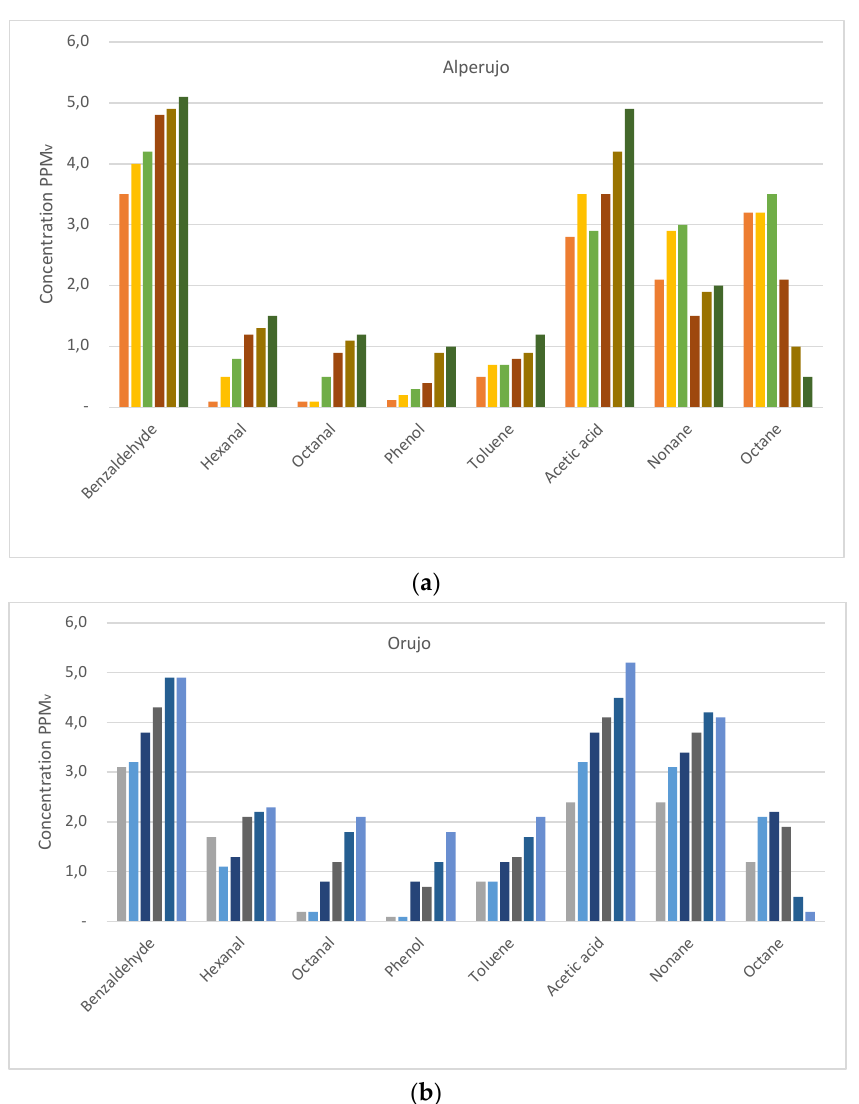
Figure 3. Monthly concentration of target VOCs found in ( a ) alperujo and ( b ) orujo drying emissions. In these graphs, bars of the groups represent each month where the experimentation was carried out between July to December from left to right.